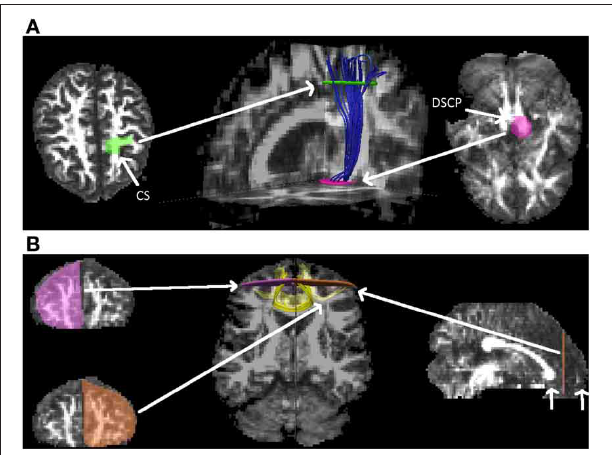
FIGURE 3 | The two fiber tracts, CST and Fminor , subject to quantitative analysis. (A) The corticospinal tract ( CST ) in one of the subjects, extracted by using one ROI (pink surface) on the cerebral peduncle at the level of the decussation of the superior cerebellar peduncle (DSCP) and one ROI (green surface) at the central sulcus (CS) after the bifurcation to the motor and sensory cortex. (B) The forceps minor ( Fminor ) in one of the subjects, extracted in a coronal slice by using two ROIs (pink and brown surfaces) at the mid-point between the anterior tip of the frontal lobe and the anterior edge of the genu of the corpus callosum (indicated with short white arrows), in each hemisphere.